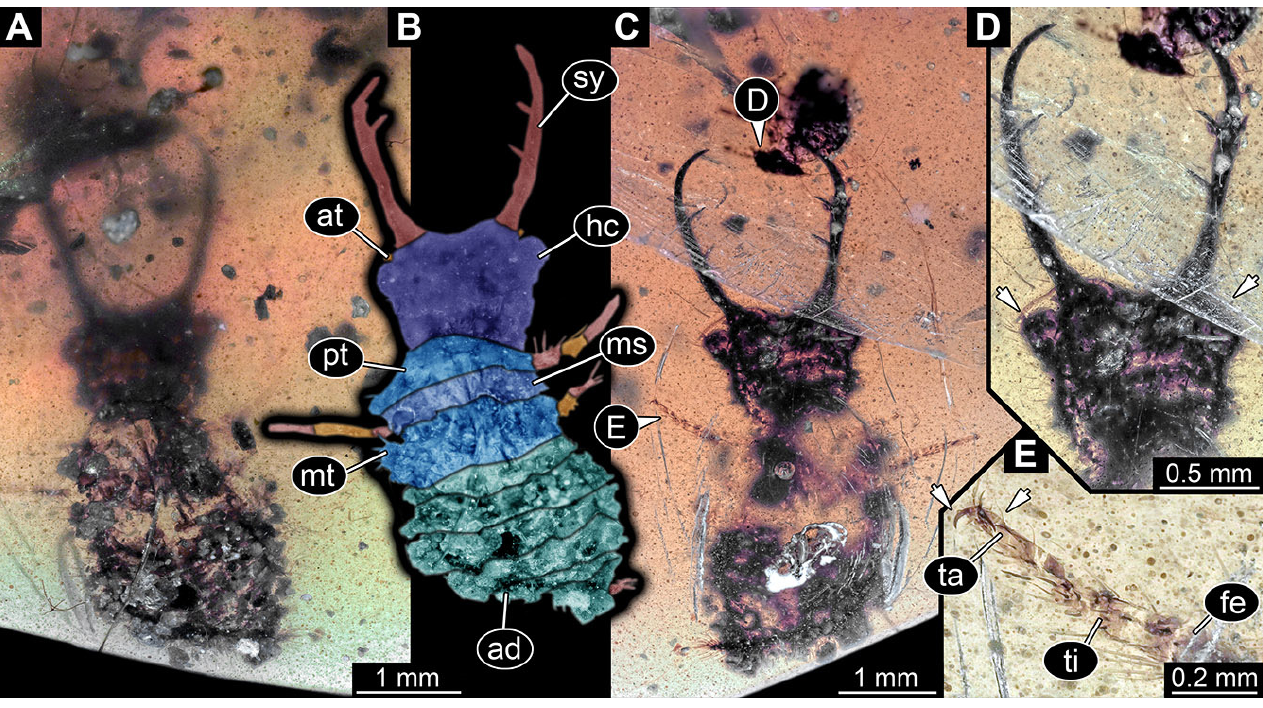
Figure 22. Fossil owllion larva, specimen 3235 (PED 0282), Cretaceous Kachin amber, Myanmar. ( A ) Overview, dorsal. ( B ) Color-marked version of ( A ). ( C ) Overview, ventral. ( D ) Close-up on head capsule with fields of stemmata (arrows). ( E ) Close-up on locomotory appendage with claws (arrows). Abbreviations: ad = abdomen; at = antenna; fe = femur; hc = head capsule; ms = mesothorax; mt = metathorax; pt = prothorax; sy = stylet; ta = tarsus; ti = tibia. 25. Specimen 3236 (PED 0318), preserved in Cretaceous Kachin amber, Myanmar. Spec-